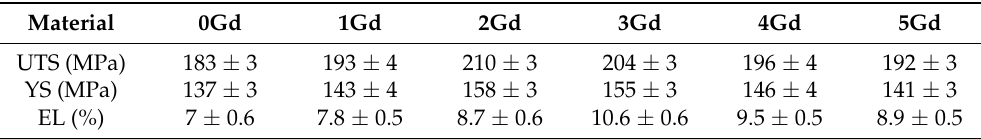
Figure 7. Engineering stress–strain curves at room temperature of the Mg–2.0Zn–0.5Zr–xGd alloys. Table 1. Mechanical properties of Mg–2.0Zn–0.5Zr–xGd alloys.